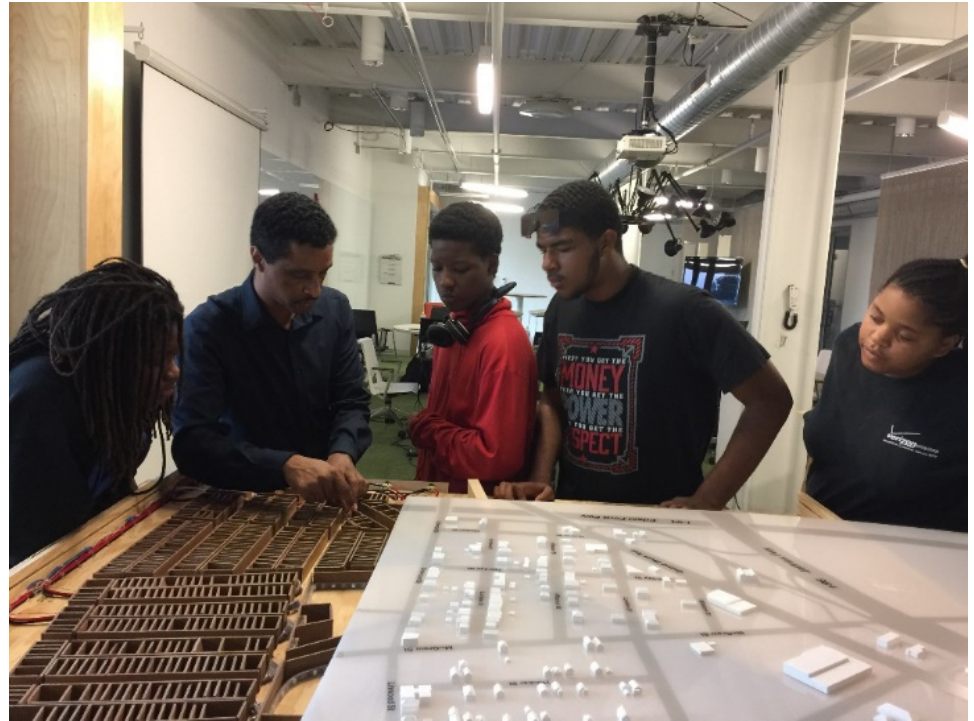
Figure 5. Middle and high school students working with architecture students on mapping and design.